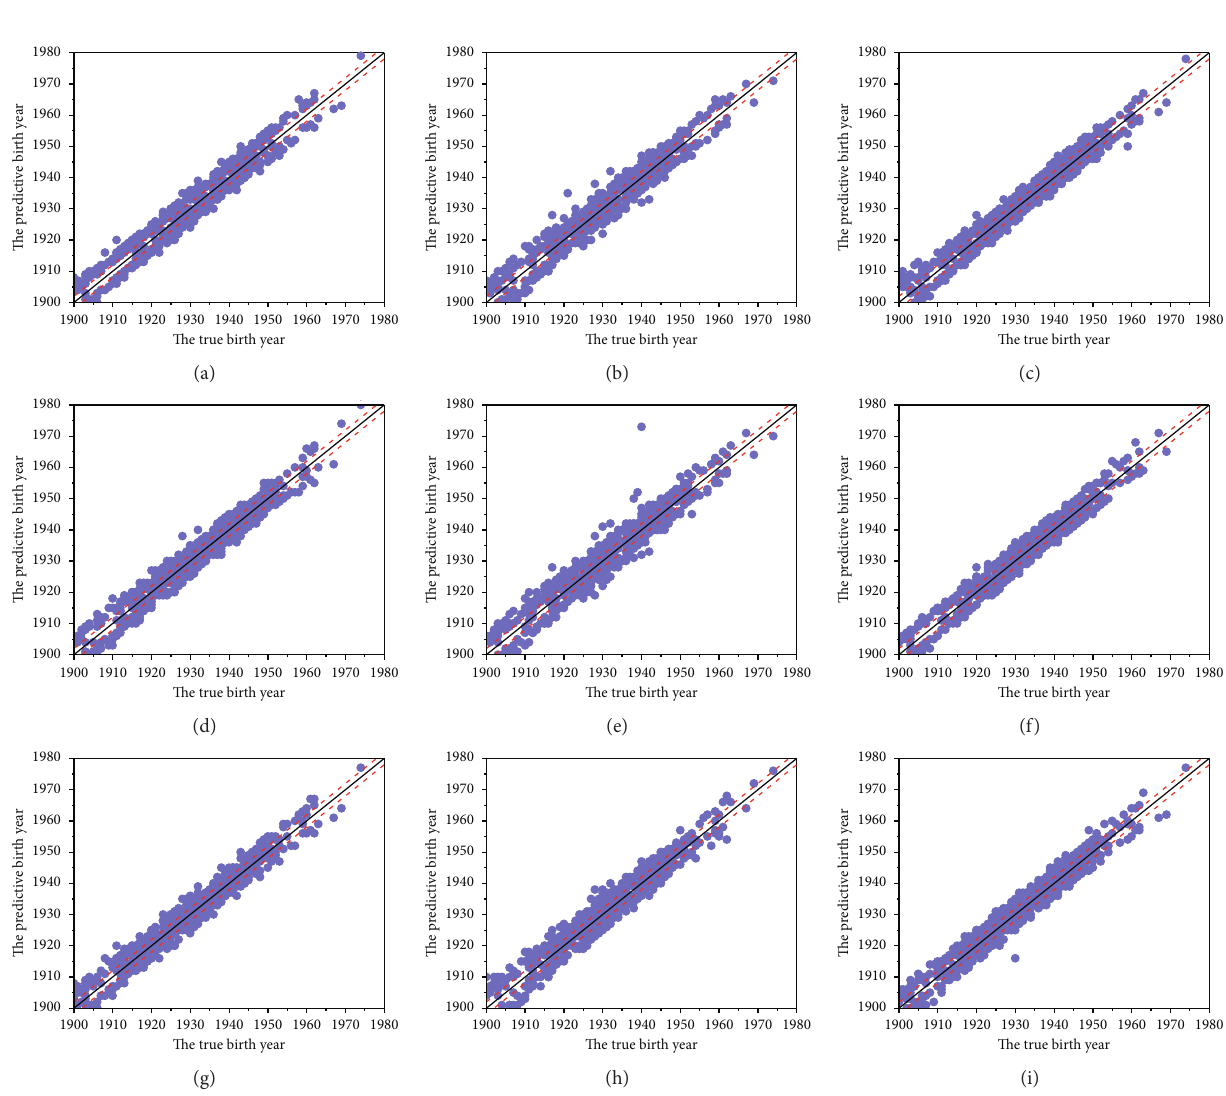
Figure 7: The prediction results under 30% loss of data by SVR, GBDT, and XGBoost. (a) XGBoost S . (b) XGBoost C . (c) XGBoost SC .